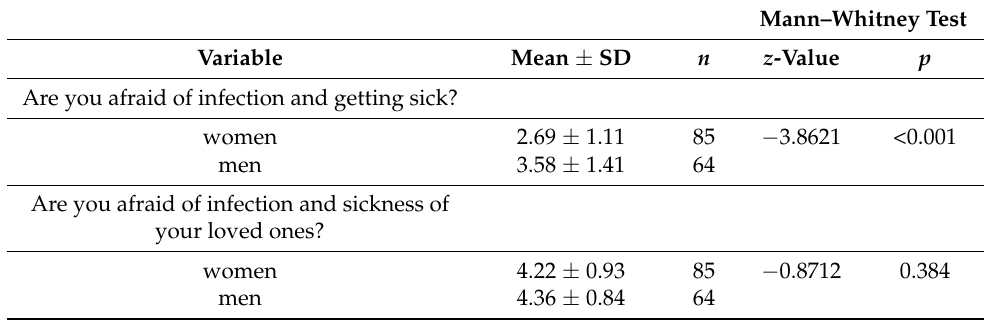
Table 5. Comparison of mean of the afraid of infection and getting sick with the gender.